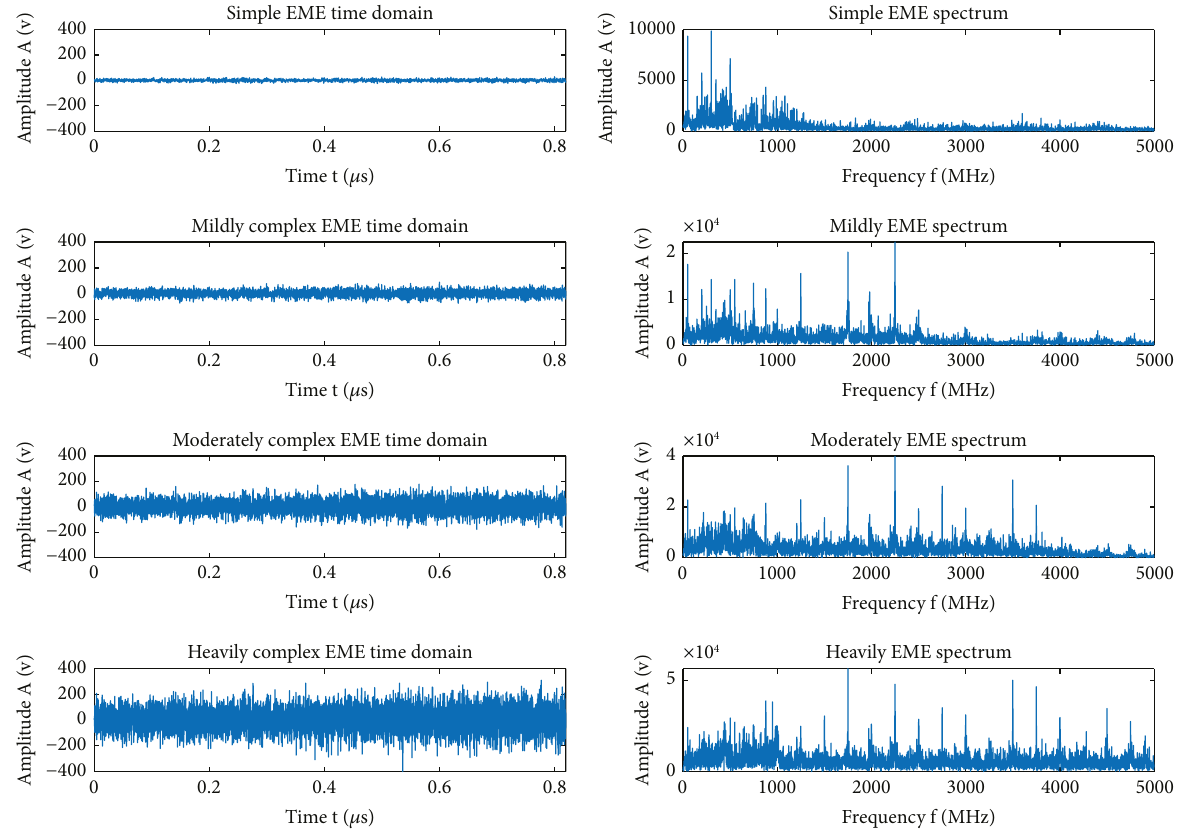
Figure 4: Simulation for EME